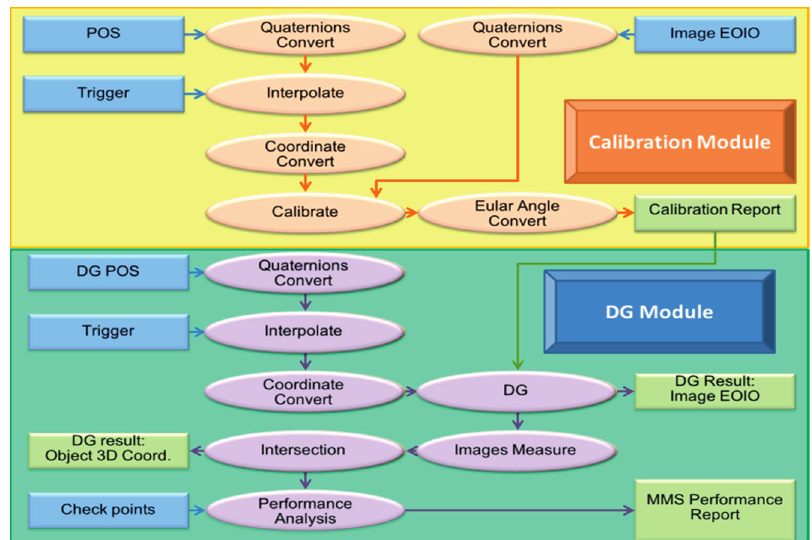
Figure 17. Data processing procedure.